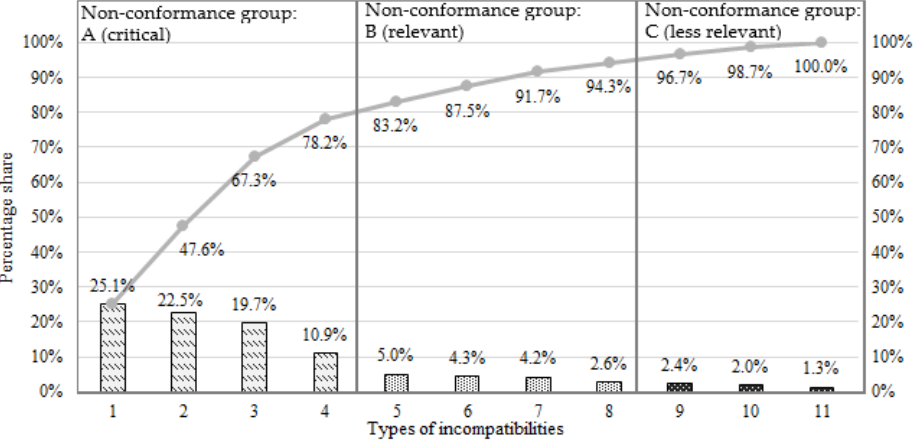
Figure 5. Pareto–Lorenz diagram of inconsistency. Figure 5. Pareto –Lorenz diagram of inconsistency. Figure 5. Pareto –Lorenz diagram of inconsistency.